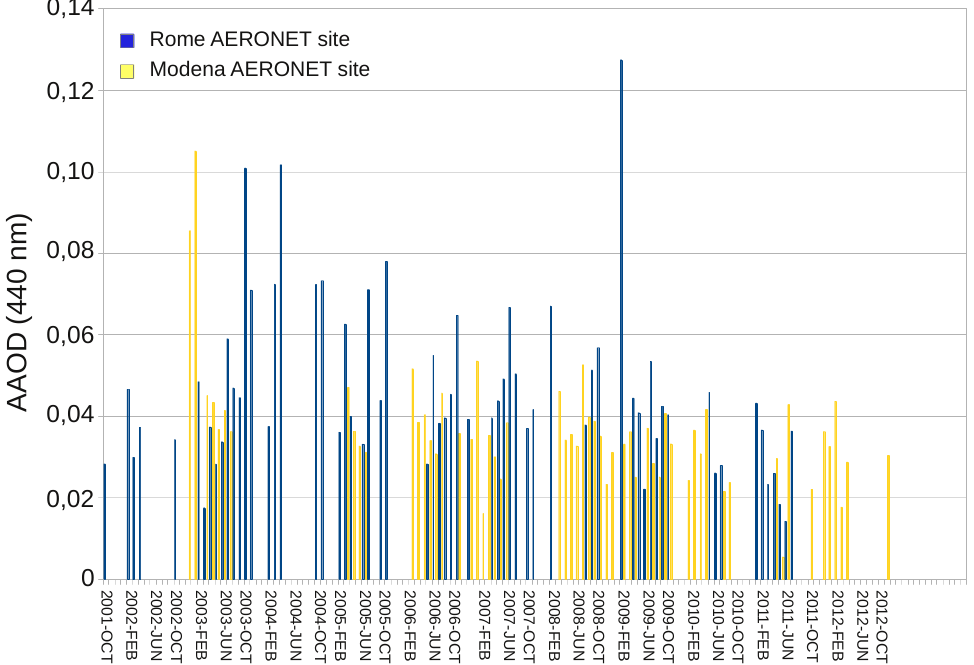
Fig. 6. Absorbing Aerosol Optical Depth, AAOD (Level 2, at 440nm) estimated at Rome and Modena for the 2001 to 2012 period. The uncertainty is about ±